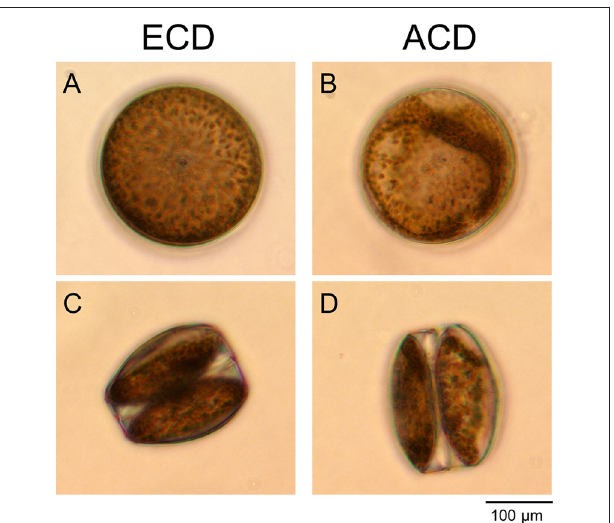
FIGURE 2 | Chloroplast distribution in cells of Coscinodiscus granii . (A,C) Even chloroplast distribution (ECD); (B,D) An altered chloroplast distribution (ACD) can be observed after harmful light doses in some of the cells. View from the top (A,B) and from the side (C,D) .